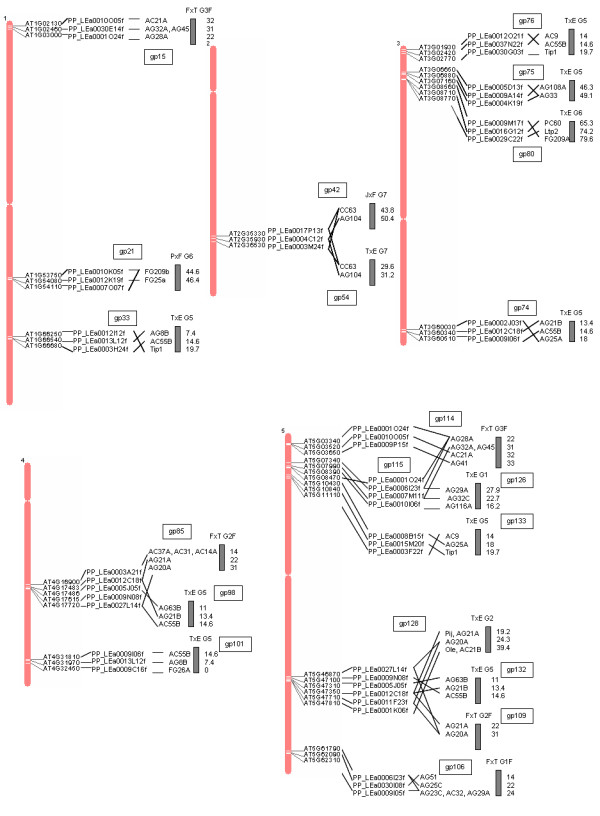
Conserved syntenic regions with three or more gene pairs between Arabidopsis genome and Prunus genome. Bolded blocks are the ones with conserved gene order.